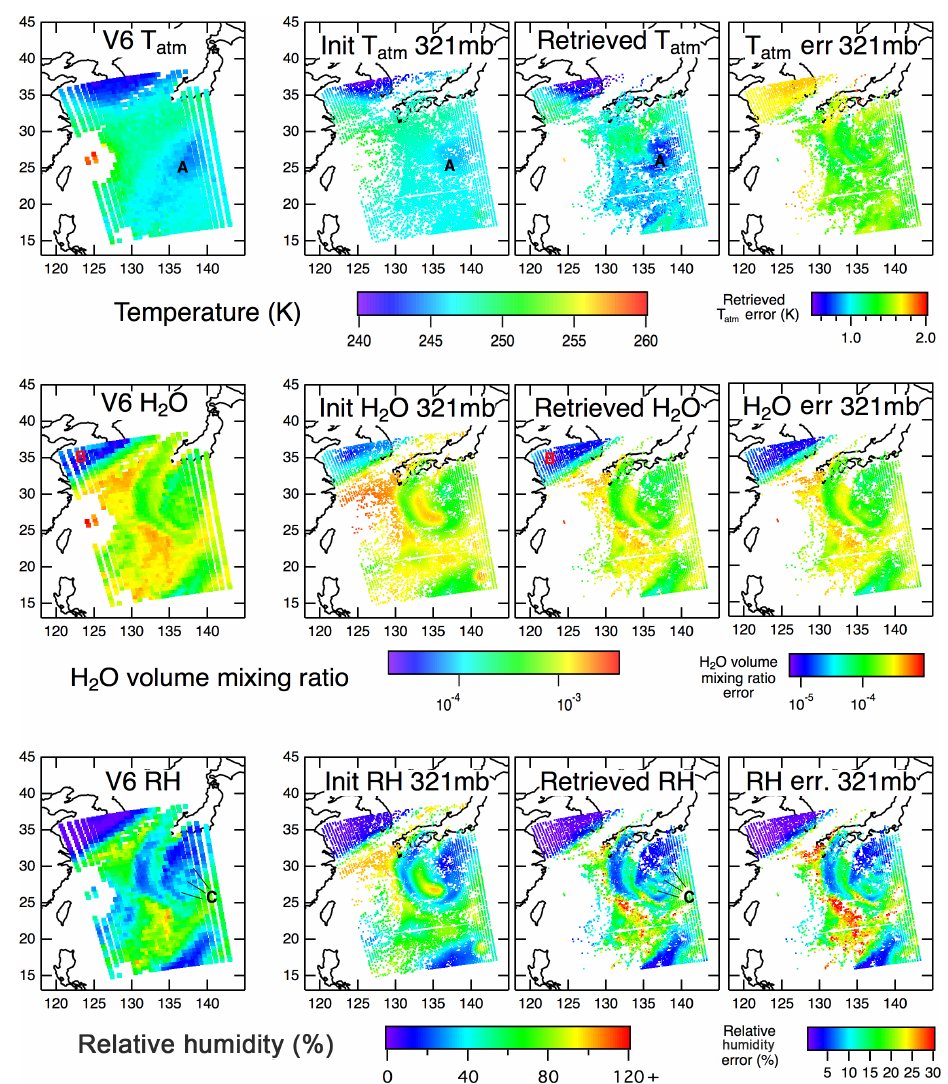
Figure 10. AIRS V6 retrieval and AIRS-OE a priori data, retrievals and errors for temperature, water vapor and relative humidity (RH) at 321mb for (daytime) Granule 44, 6 September 2002. Note that unlike Figs. 8 and 9, water vapor volume mixing ratio is on a logarithmic